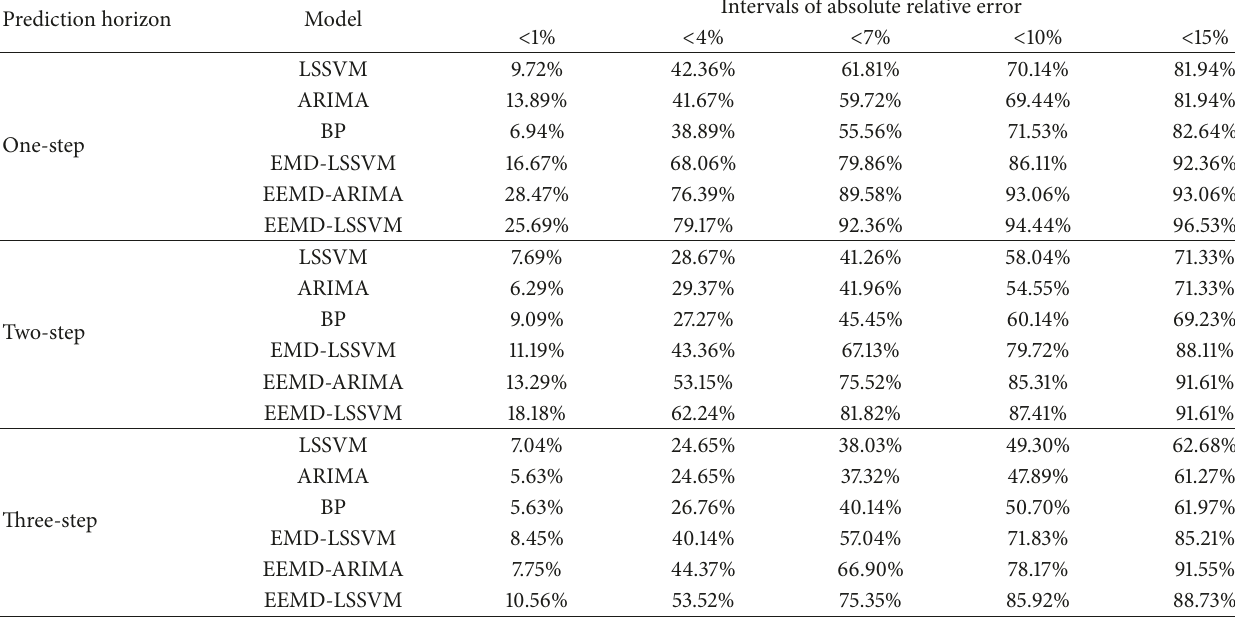
Table 8: Statistics for absolute relative error of each prediction point (Case